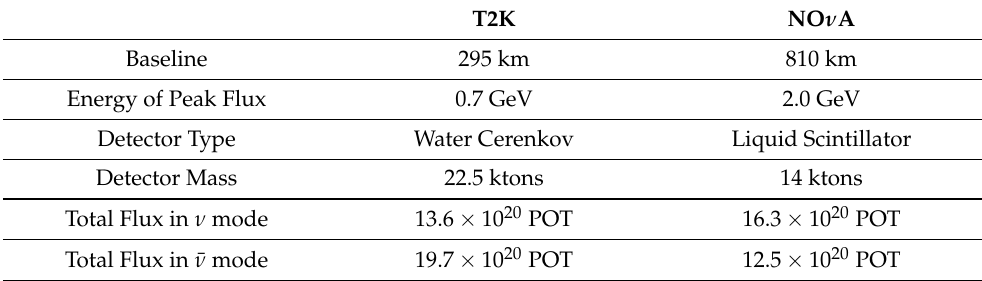
Table 2. Summary of important information of T2K and NO ν A